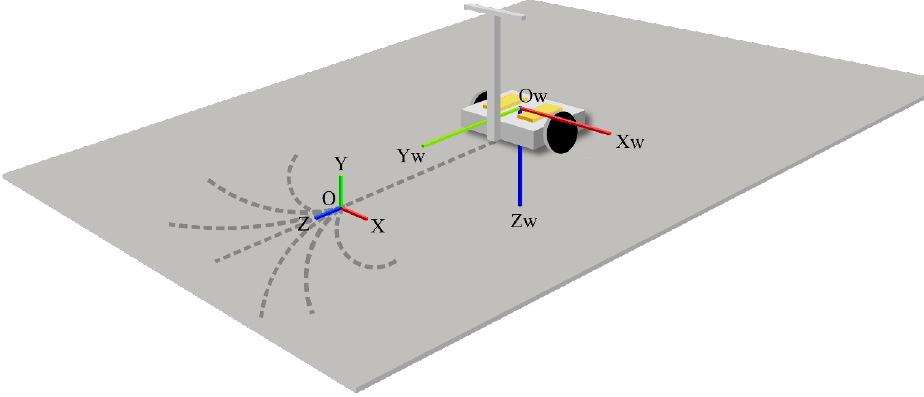
Figure 18. Coordinate system of the wearable floor reaction force meter.